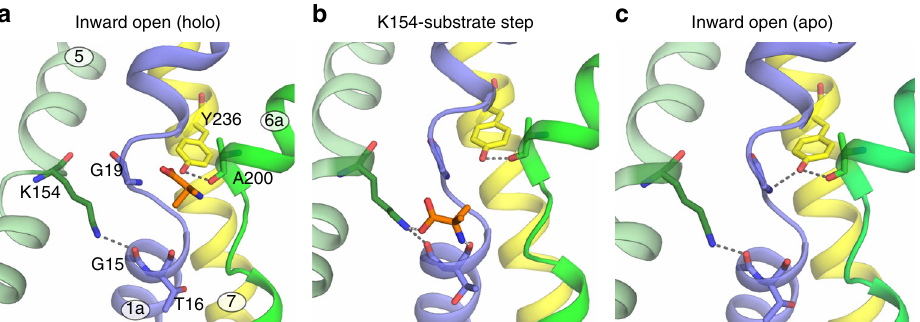
Fig. 6 Model for BasC substrate release to the cytoplasm. a 2-AIB (orange) bound BasC structure (PDB ID: 6F2W). Interactions of Lys 154 in TM5 with Gly 15 in TM1a and Tyr 236 in TM7 with Ala 200 in TM6 are shown. b Molecular dynamics analysis shows interaction of 2-AIB with the amino group of Lys 154 and the (O) backbone atom of Thr 16 in TM1a in the way of the substrate to the cytosol (snapshot extracted at 435 ns from the blue trajectory shown in Supplementary Fig. 7). c In the BasC apo structure (PDB ID: 6F2G), Gly 19 in the unwound region of TM1 approaches Tyr 236 at hydrogen bond distance. Lys 154-Gly 15 interaction is maintained all along the MD analysis and in both apo and holo structures